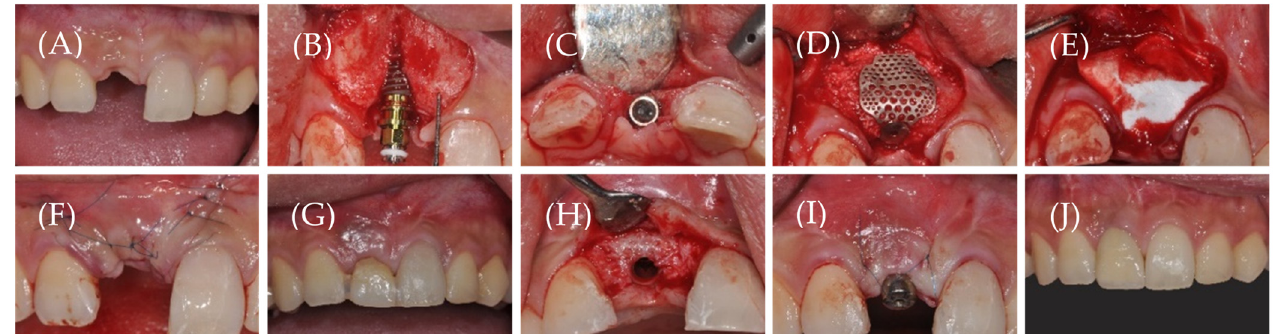
Figure 1. Surgical procedure stages. ( A ) Baseline: #11 is missing, ( B , C ) Implantation: peri-implant dehiscence bony defect is seen, ( D ) Bone grafts and 3D preformed titanium mesh application, ( E ) Collagen membrane application, ( F ) Suturing, ( G ) Healing state before second implant surgery, ( H ) Minimal incision and flap elevation: good hard tissue gain is noted, ( I ) Healing abutment installation and suturing, and ( J ) Final prosthetic restoration.